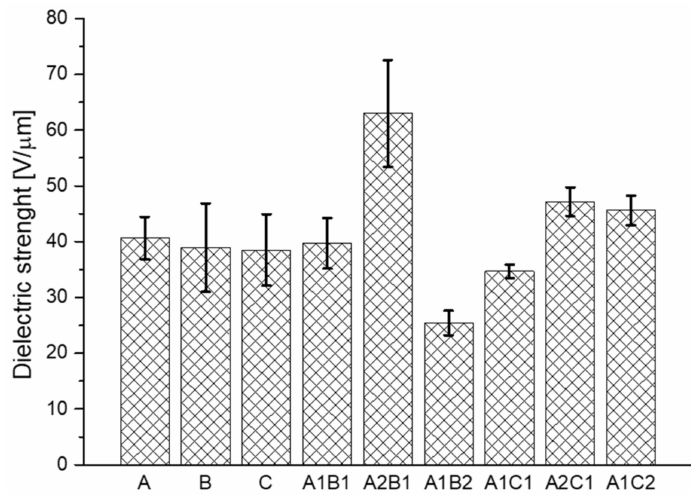
Figure 11. Dielectric strength of the prepared